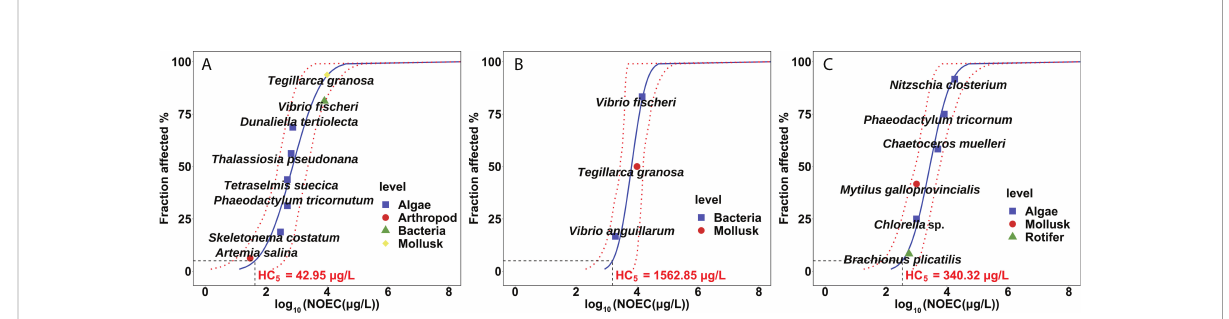
FIGURE 2 Marine species sensitivity distribution of bulk (A) ZnO, (B) CuO, and (C) TiO 2